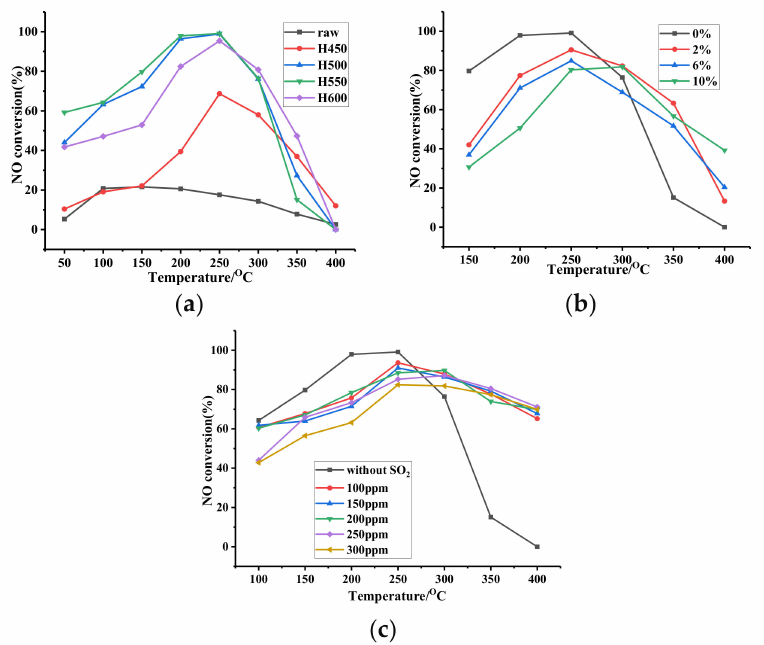
Figure 6. The NO conversion of di ff erent samples ( a ), H550 in the presence of water ( b ), and H550 in the presence of sulfur dioxide ( c ). (Reaction condition: NO = 500 ppm, NH 3 = 500 ppm, O 2 = 1.5 vol. %, and balance of Ar, GHSV = 16000 h − 1 , the NO conversion of zero means the NO concentration in the outlet over the